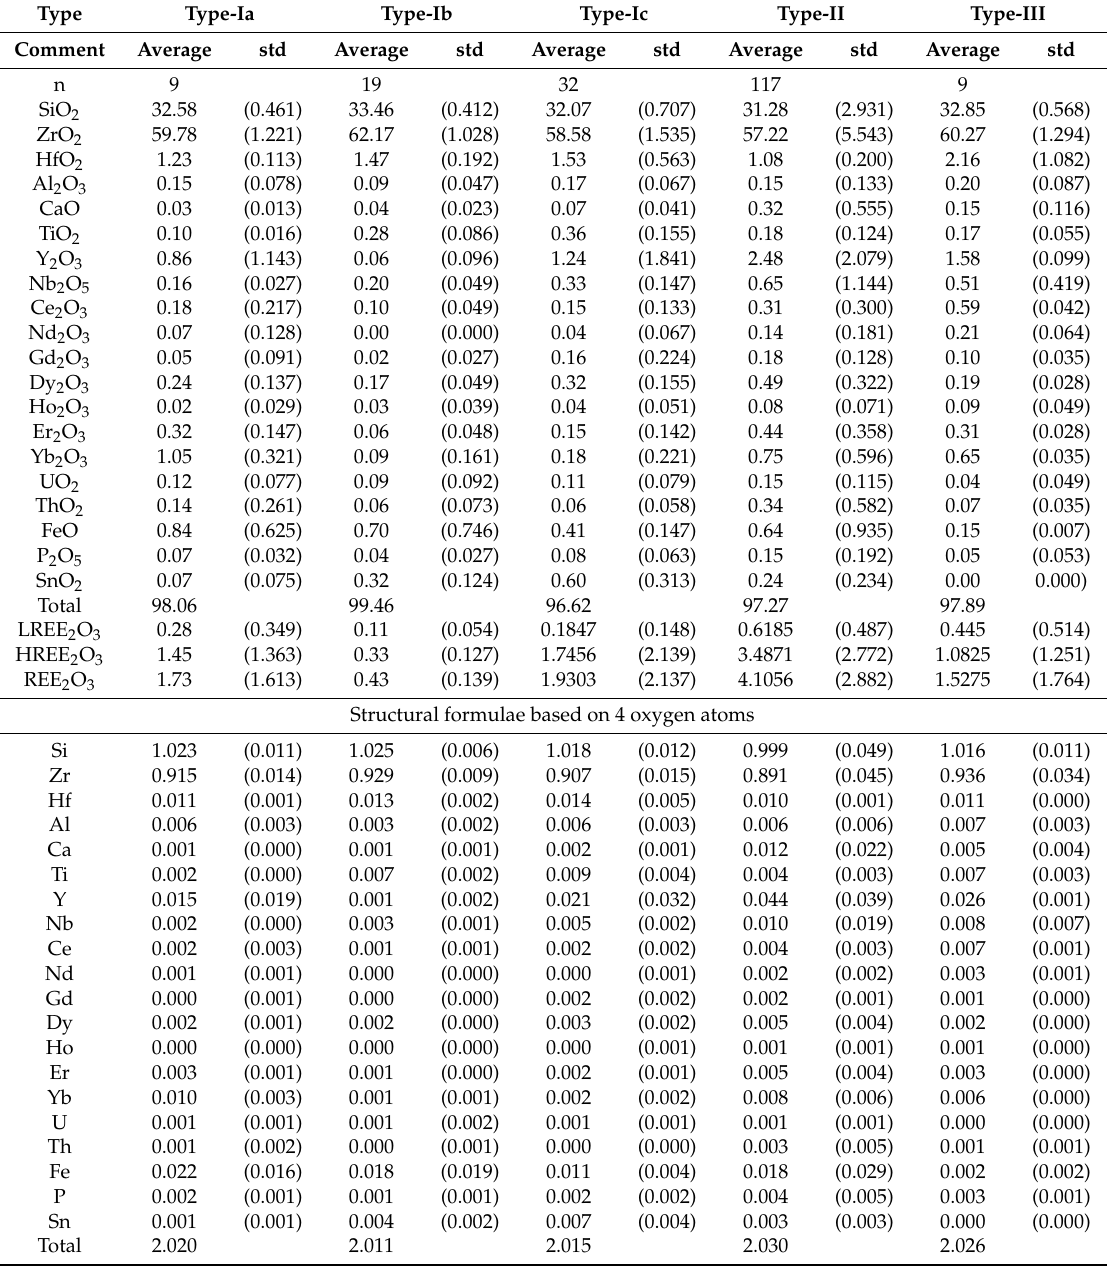
Table 1. Average value of electron probe micro analyzer (EPMA) analysis data in